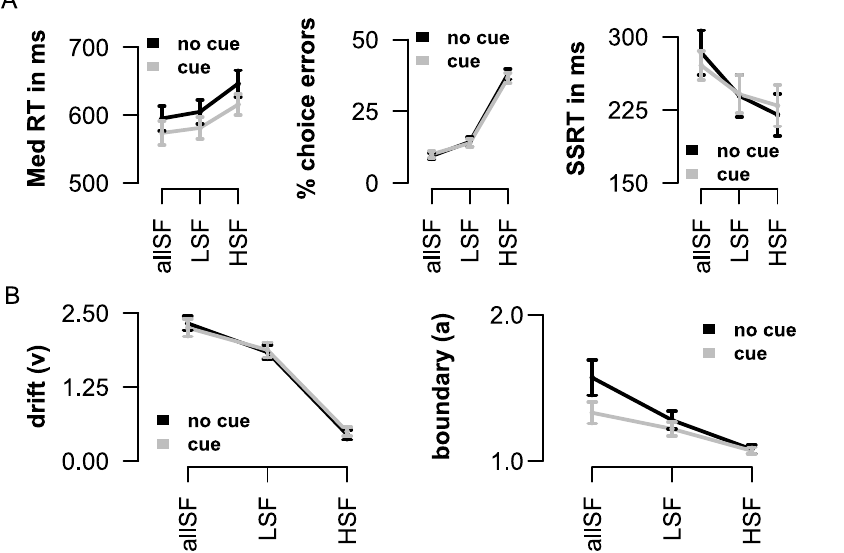
Figure 6. Experiment 2: visual stop task, with or without prior information about spatial frequency type (cue). A) In both experiments Go RT (left panel) and % choice errors (middle panel) increased when spatial frequency information was removed. Again, response inhibition was more efficient when categorization became more difficult (right panel). Prior knowledge about frequency type improved only response initiation (Go RT). B) Parameter estimates obtained from HDDM showed a decrease in ‘‘drift rate’’ ( v ) (left panel) and decision ‘‘boundaries’’ ( a ) (right panel) with the removal of spatial frequency information.